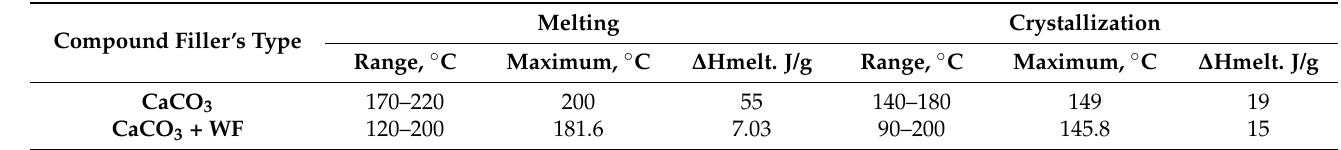
Table 6. Thermal behaviour of compounds with and without wood flour and the same CaCO 3 amount.